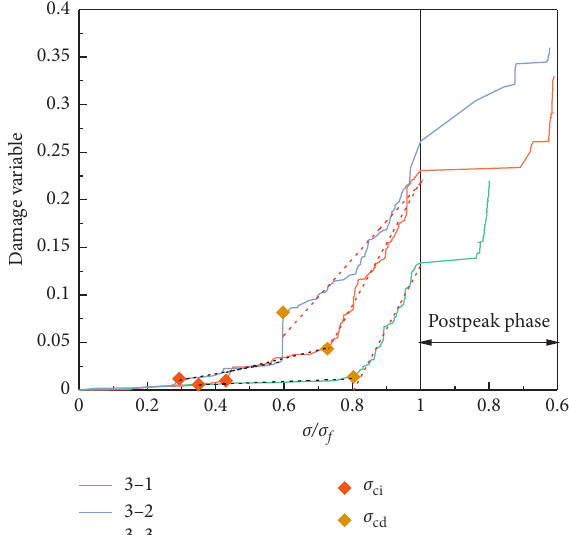
Figure 7: Stress threshold and the damage evolution curve in 10 − 3 s − 1